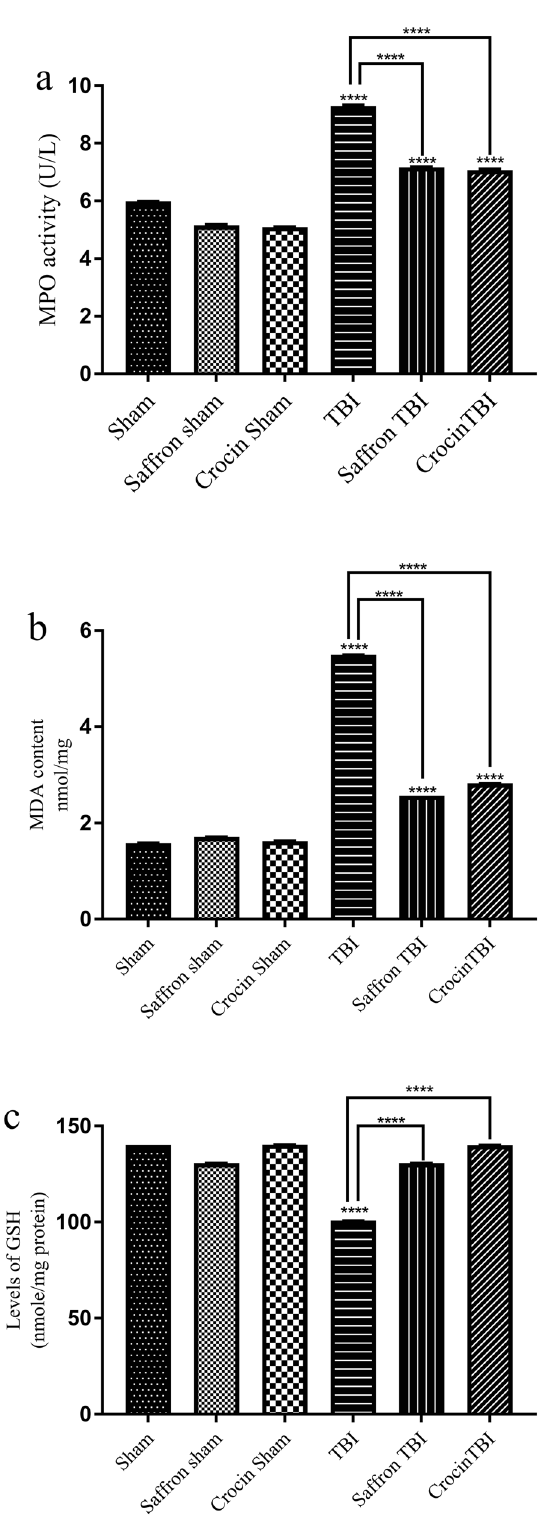
Figure 7. Effect of saffron extract and crocin on MPO activity, MDA content, and GSH levels. ( a ) The significant increase in activity of MPO in TBI, saffron TBI and crocin TBI groups and shows the relative decline in MPO activity in saffron TBI and crocin TBI groups compared to the TBI group. MDA content is expressed in ( b ). The level of MDA is significantly high in the TBI, saffron TBI, and crocin TBI groups. ( c ) GSH levels in the experimental groups. TBI caused a significant decrease in GSH levels while saffron and crocin treatment restored normal GSH levels. Both treatments were significantly effective in reducing MDA levels. Data are represented as means of three determinations ± SD. (****) corresponds to p-value <